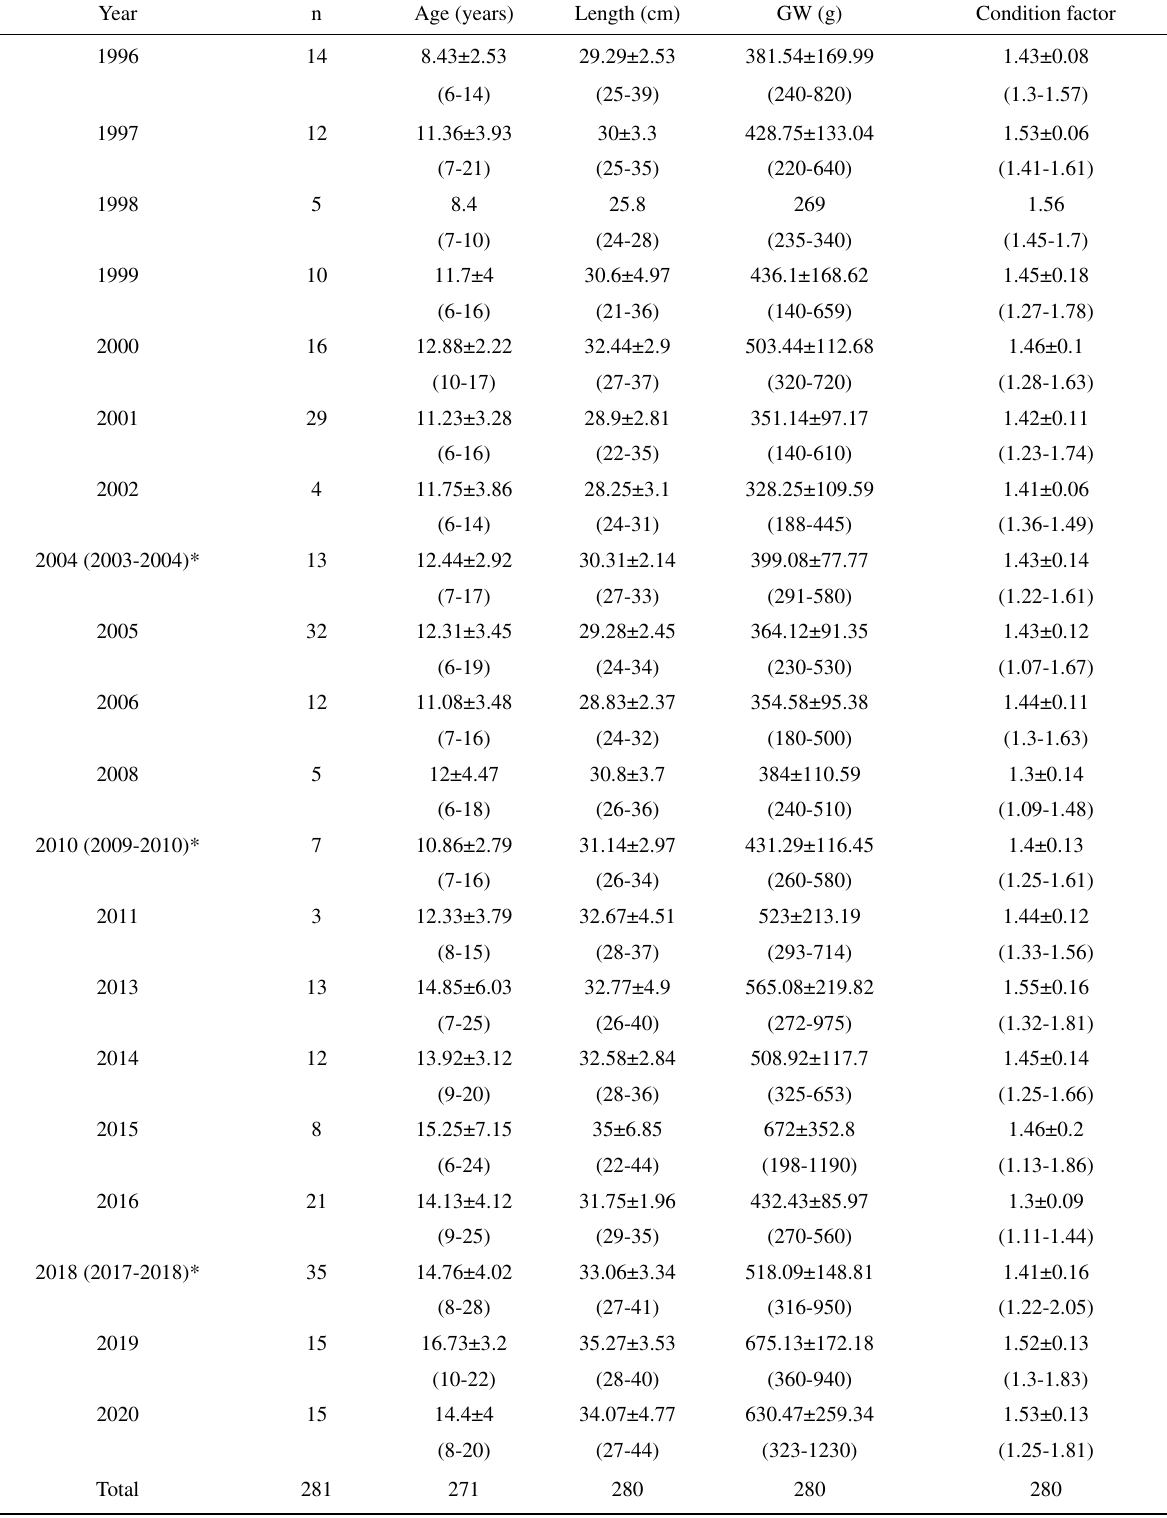
1. – Summary statistics of the female S. fasciatus maternal traits: age, fork length, gutted weight (GW) and condition factor. Numbers indicate the average ± standard deviation, with ranges shown in parentheses. Years with merged data required to increase sampling size are indicated with asterisks and correspond to the year label used in the